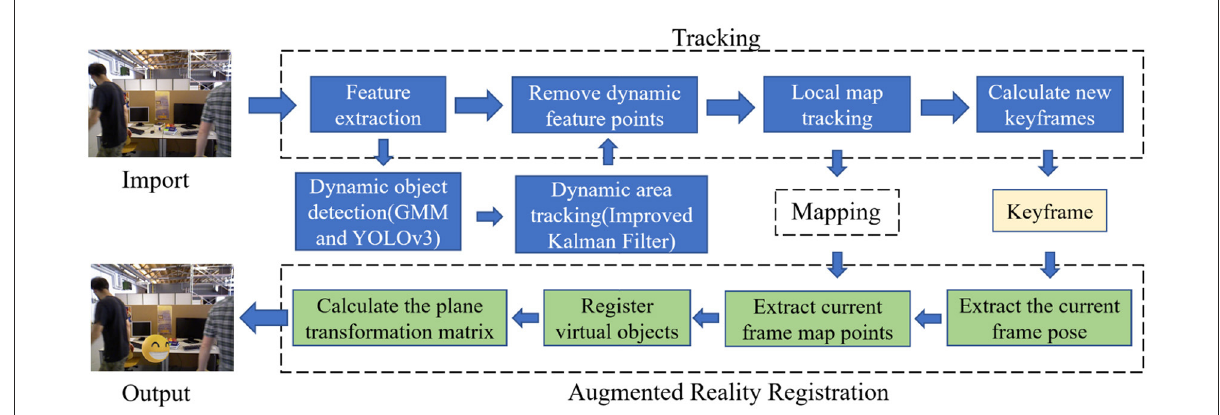
FIGURE1 System diagram. This system mainly consists of three parts: tracking thread, mapping thread, and Augmented Reality Registration thread. The tracking thread uses GMM combined with the YOLOv3 method for dynamic object detection and uses the improved Kalman filter method for dynamic object tracking. Next, it removes the feature points of dynamic objects in the keyframes and transfers the keyframes that retain the static feature points to the augmented reality registration thread. In the Augmented Reality Registration thread, it registers virtual objects through the map points and camera poses of the current frame and tracks virtual objects through matrix